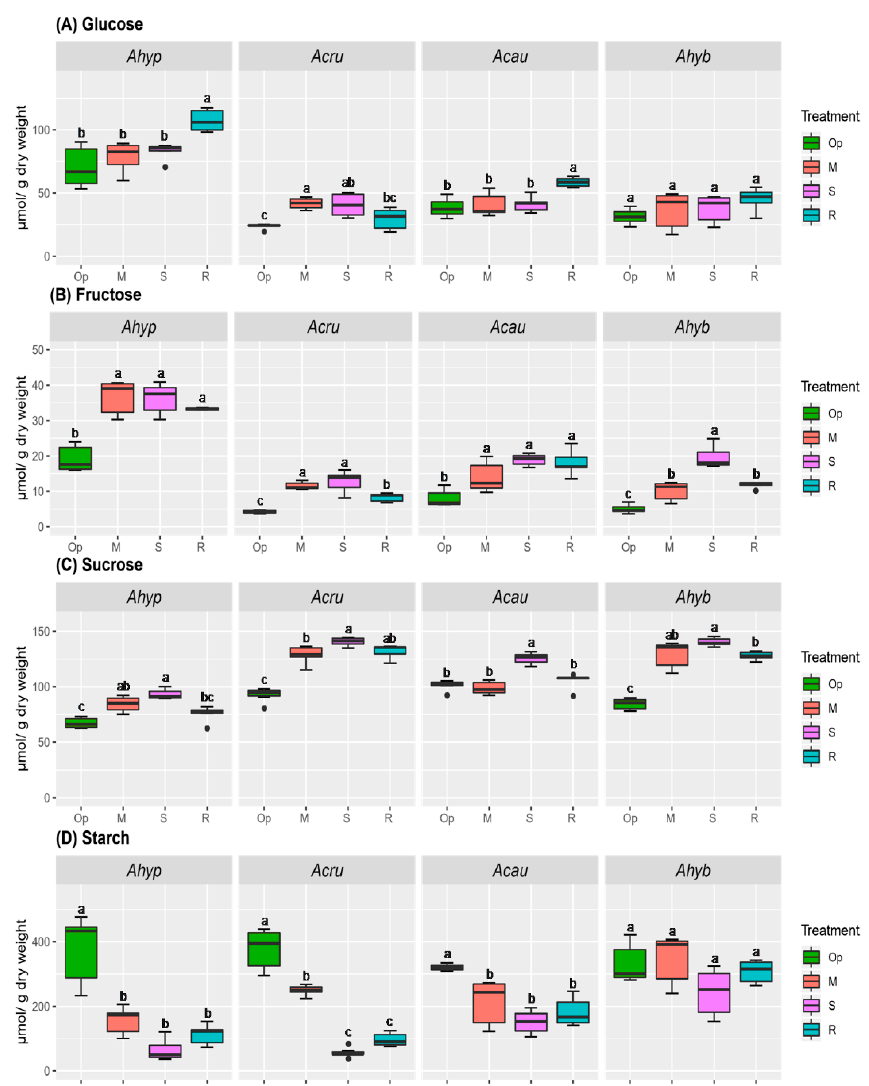
Figure 2. Non-structural carbohydrates in roots of amaranth plants subjected to water-deficit stress. ( A ) Glucose, ( B ) fructose, ( C ) sucrose and ( D ) starch content in roots of Amaranthus hypochondriacus (Ahypo), A. cruentus (Acru), A. caudatus (Acau) and A. hybridus (Ahyb) plants growing in optimal conditions (Op), subjected to moderate (M) or severe (S) water-deficit stress, or allowed to recover from S, 1 day after normal watering was restored (R). Different letters over the box-and-whisker plots represent statistically significant differences at p ≤ 0.05 (Tukey Kramer test; n = 9). Box-and-whisker plots show high, low, and median values. The results shown are those obtained from a